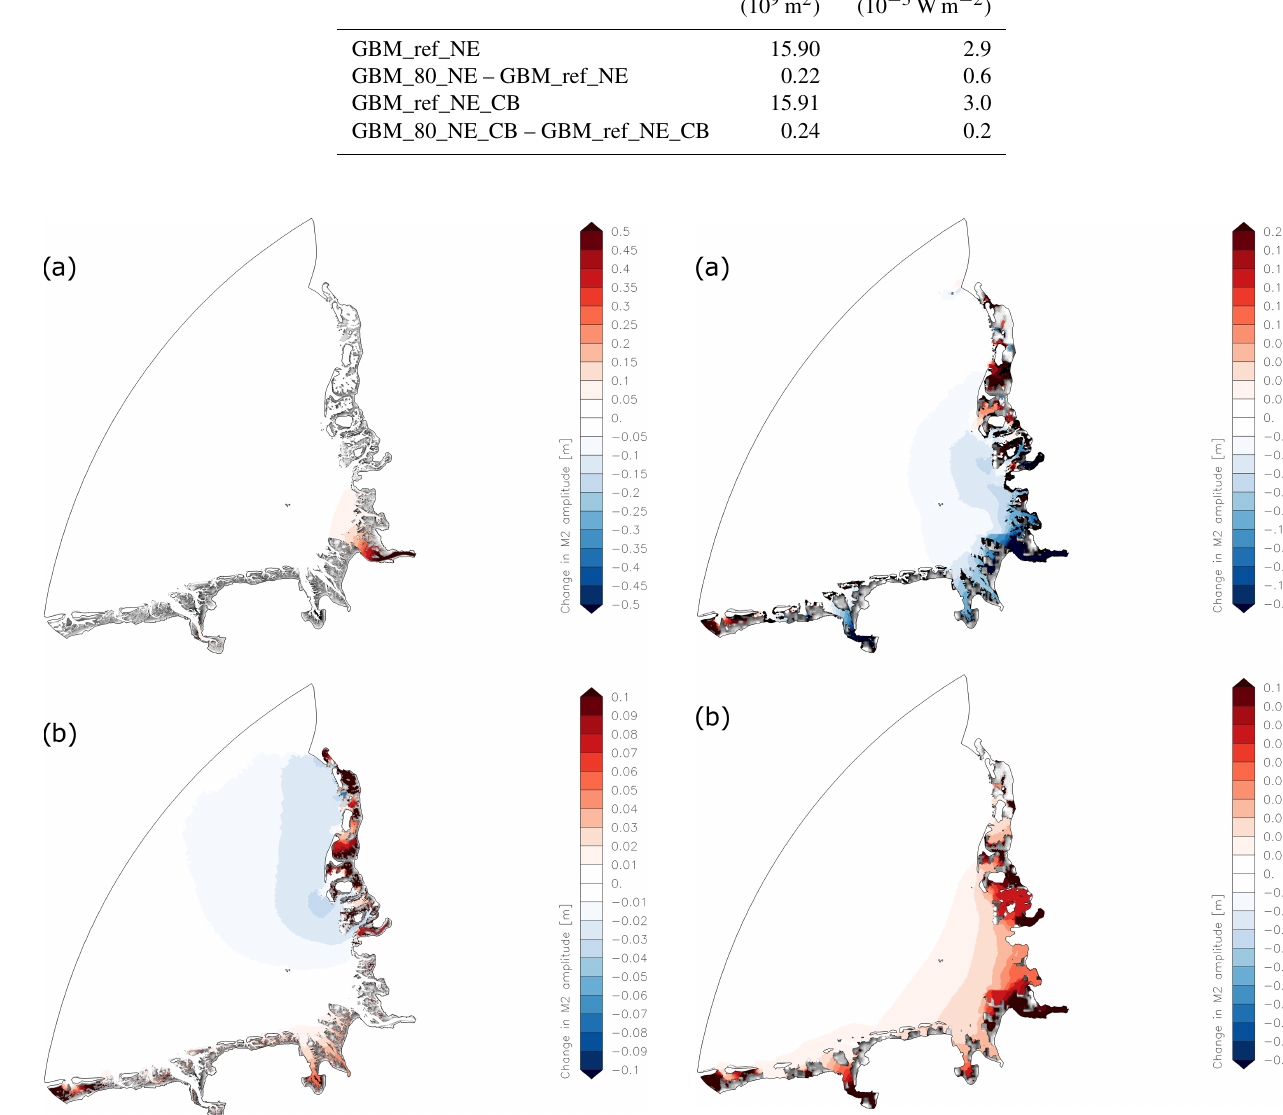
the shallow part of the German Bight out to 20 m depth it also decreases in comparison to the reference simulation. Gener- ally, mean currents decrease in the channels in the model run with 10 m (Fig. 10). This is consistent with the smaller values of dissipation